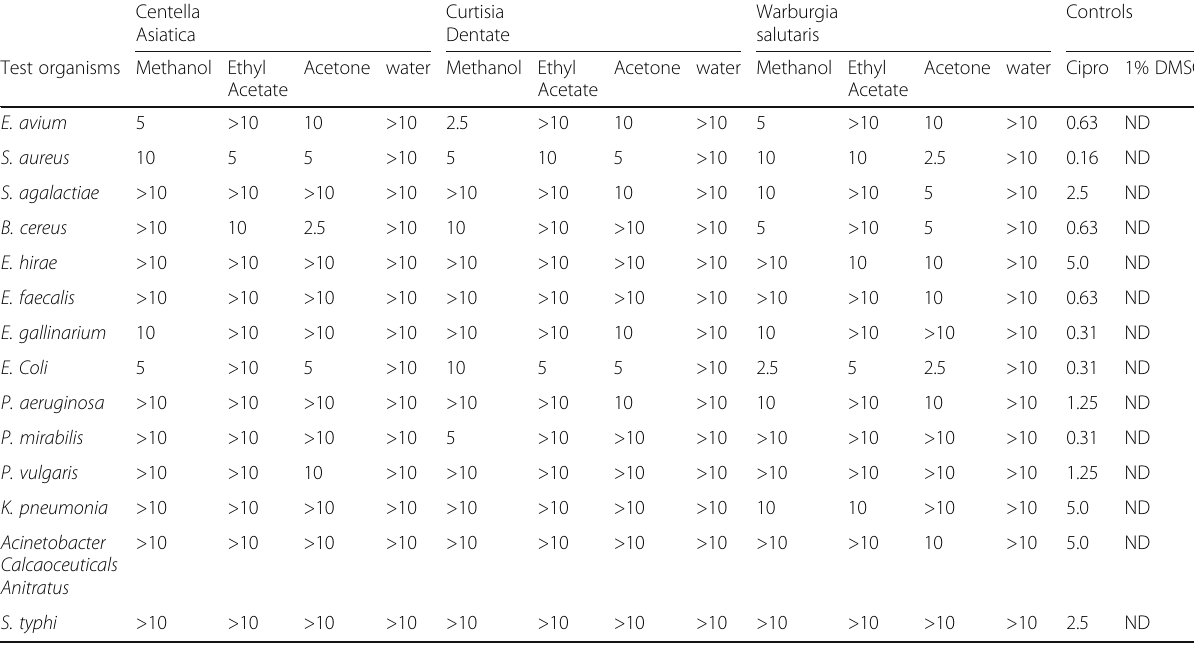
Table 5 The MBC (mg/ml) values of Centella asiatica , Curtisia dentate and Warbugia salutaris extracts against bacteria Centella Curtisia Asiatica